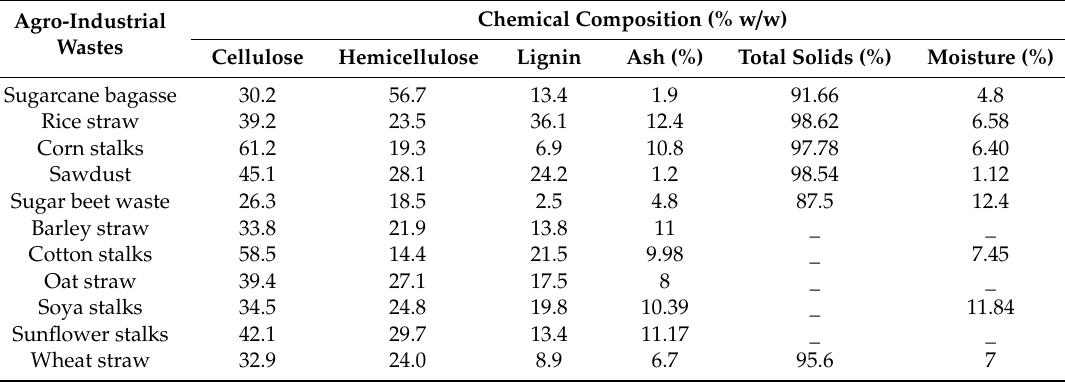
Table 2. Chemical composition of common forms of agricultural waste